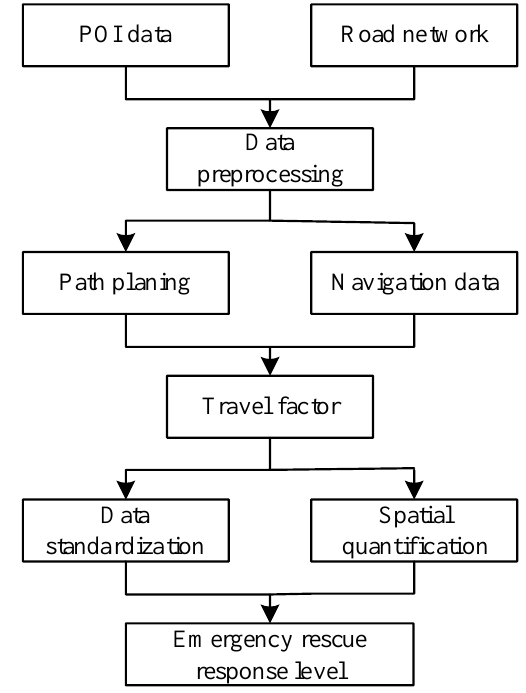
Figure 2 . Technology